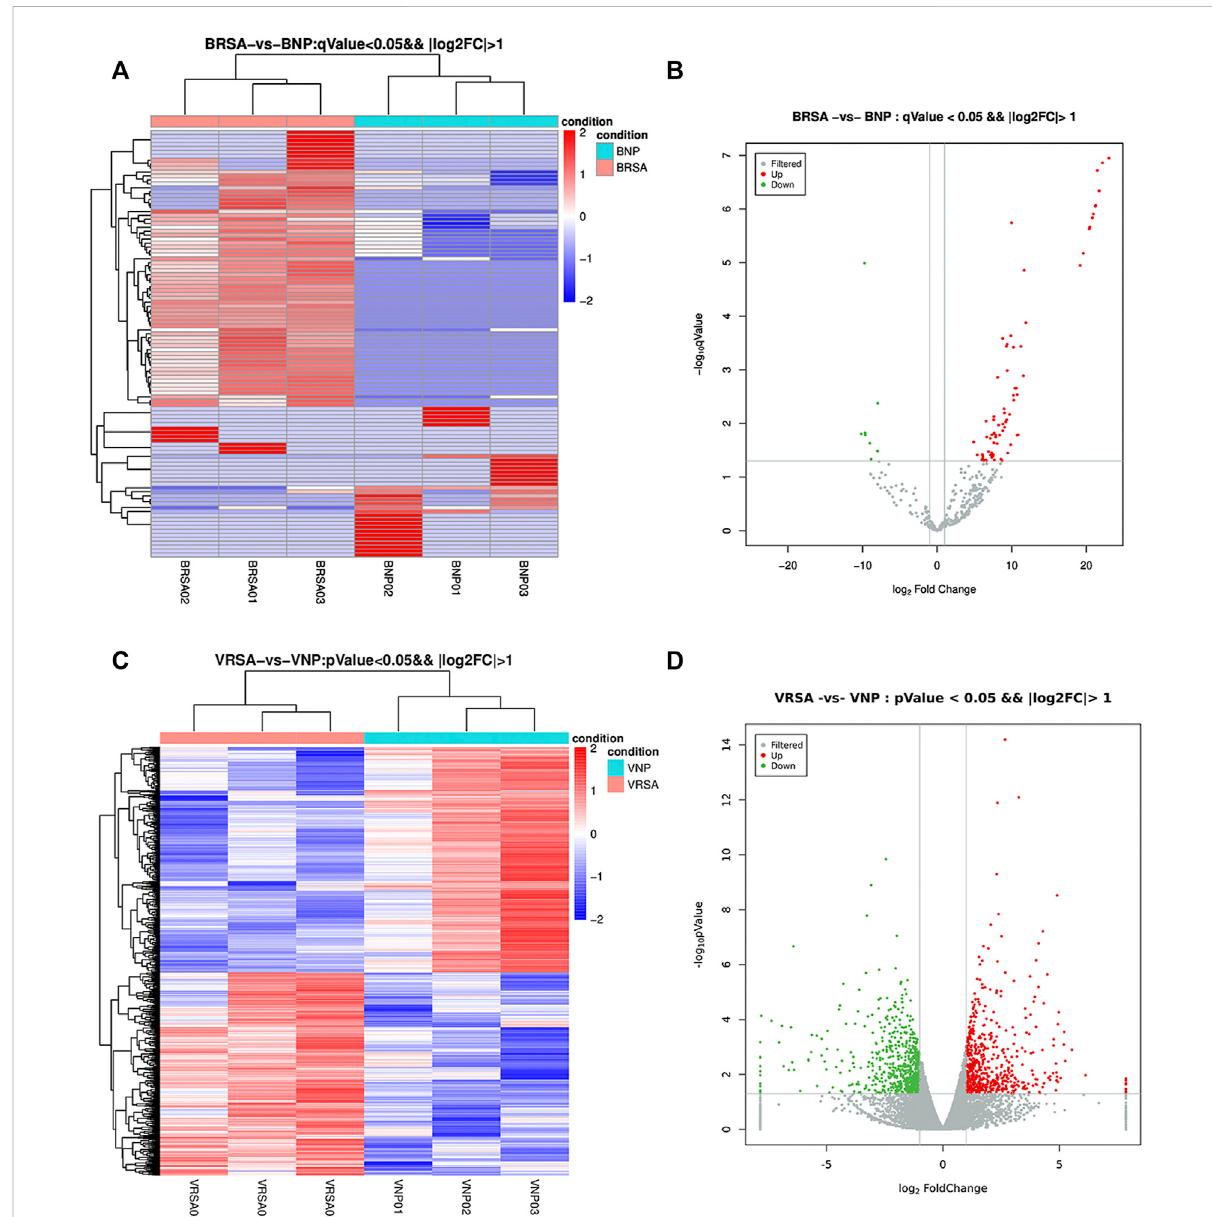
FIGURE 1 Expression pro fi les of circulating miRNAs and placental mRNAs in the NP and RPL groups ( n = 3 per group). (A) heatmap of circulating miRNAs. (B) volcano plot of circulating miRNAs. (C) heatmap of placental mRNAs. (D) volcano plot of placental mRNAs.